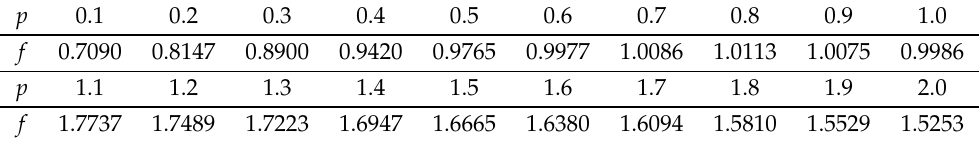
Table 3. Price of the American option with different p (compound trapezoid